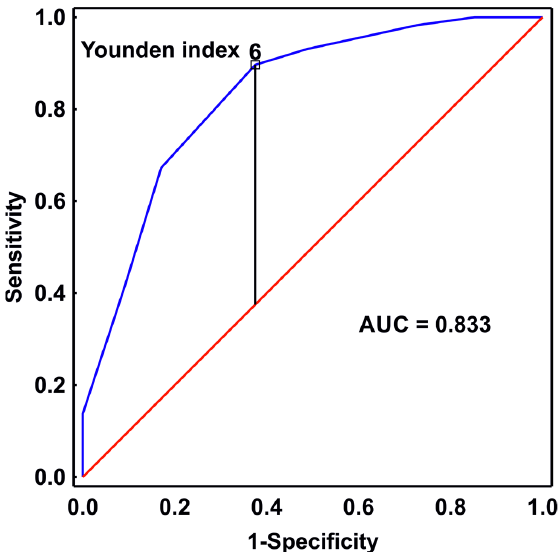
Figure 1. The receiver operating characteristic (ROC) curve illustrates the diagnostic ability of the mNUTRIC score calculated in patients with sepsis on admission to the ICU as a predictor of 28-day survival with an area under the curve (AUC) of 0.833 (95% CI 0.76–0.89, p < 0.001). The results of analyzing the Younden statistics indicated the optimal cut-off value for the mNUTRIC score at 6 points.